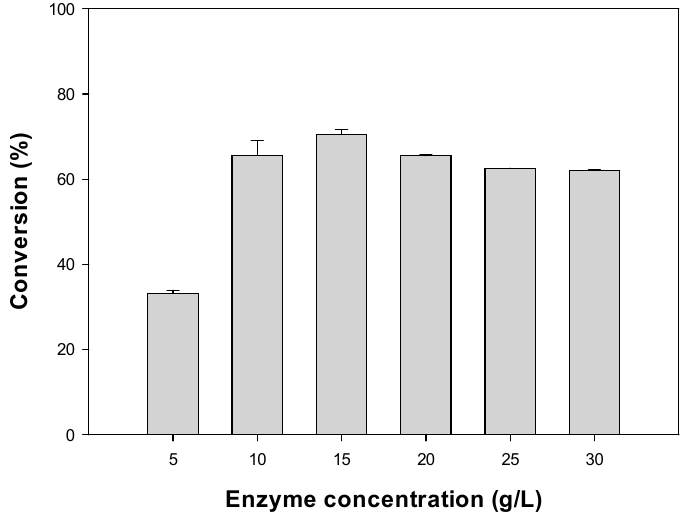
Figure 3. Effect of the selected lipase concentrations on the octyl formate conversion. Figure 3. E ff ect of the selected lipase concentrations on the octyl formate